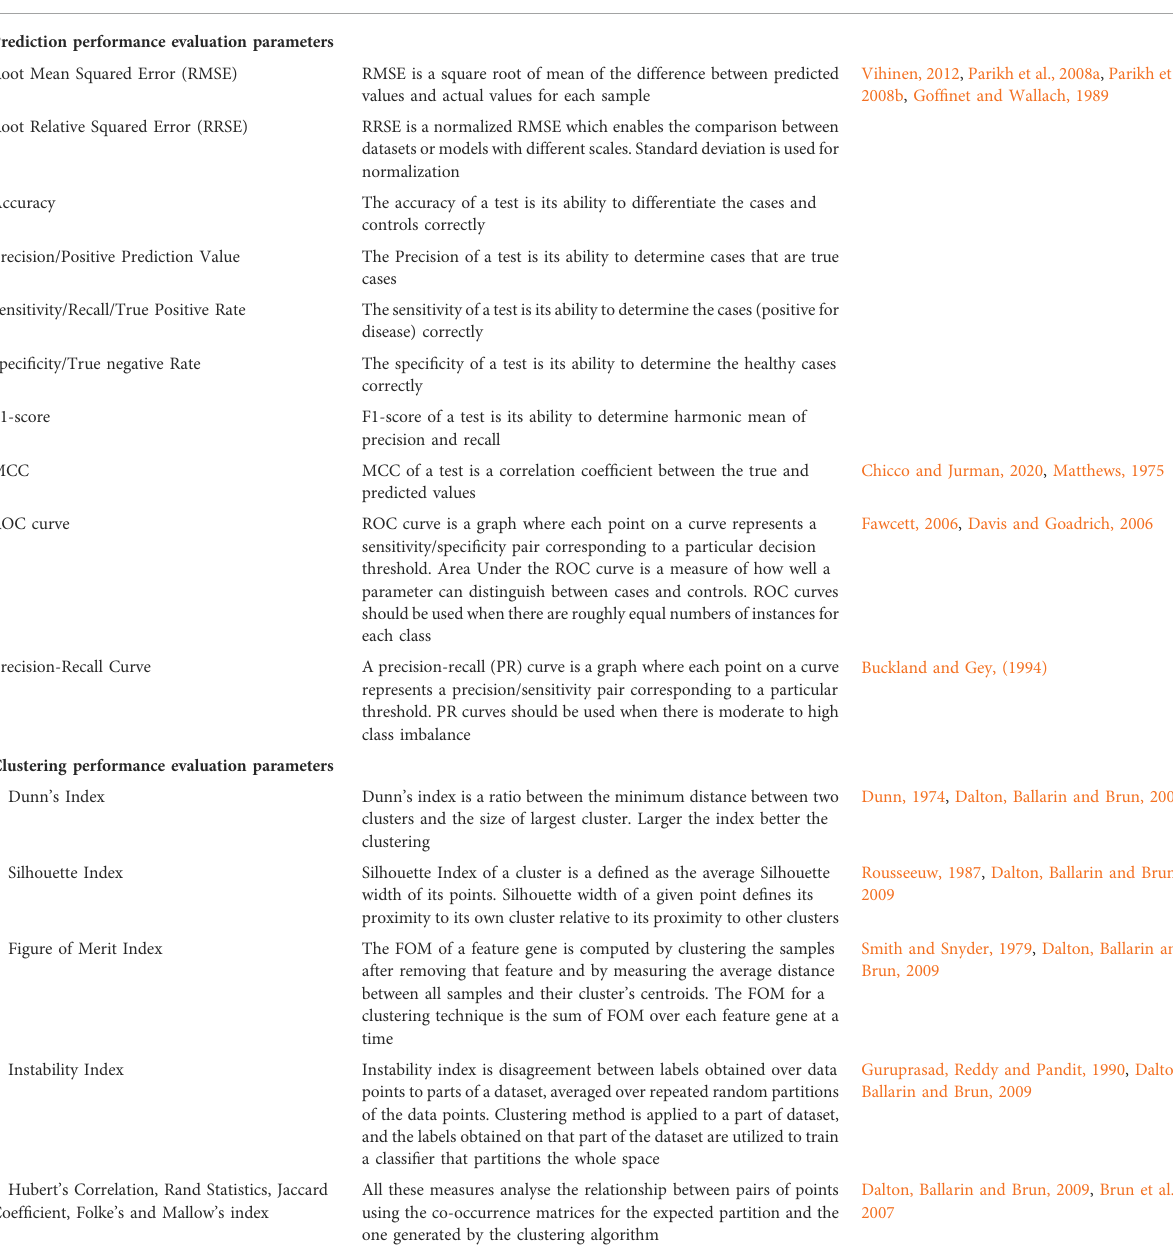
TABLE 5 Evaluation Parameters for analysis of microarray gene expression